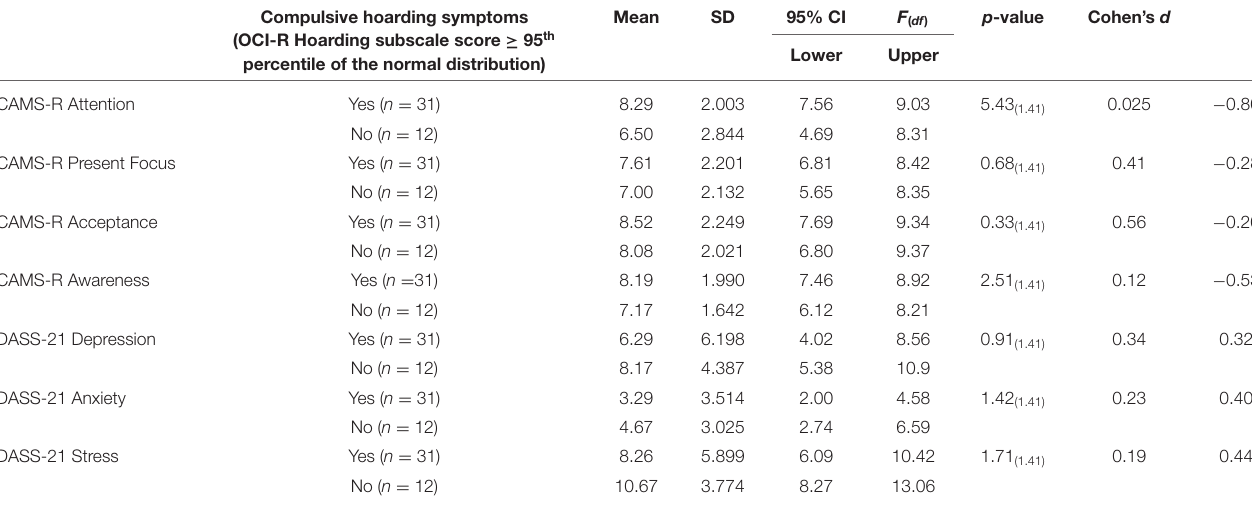
TABLE 2 | Comparison between men with and without CHS on the clinical scales ( n =